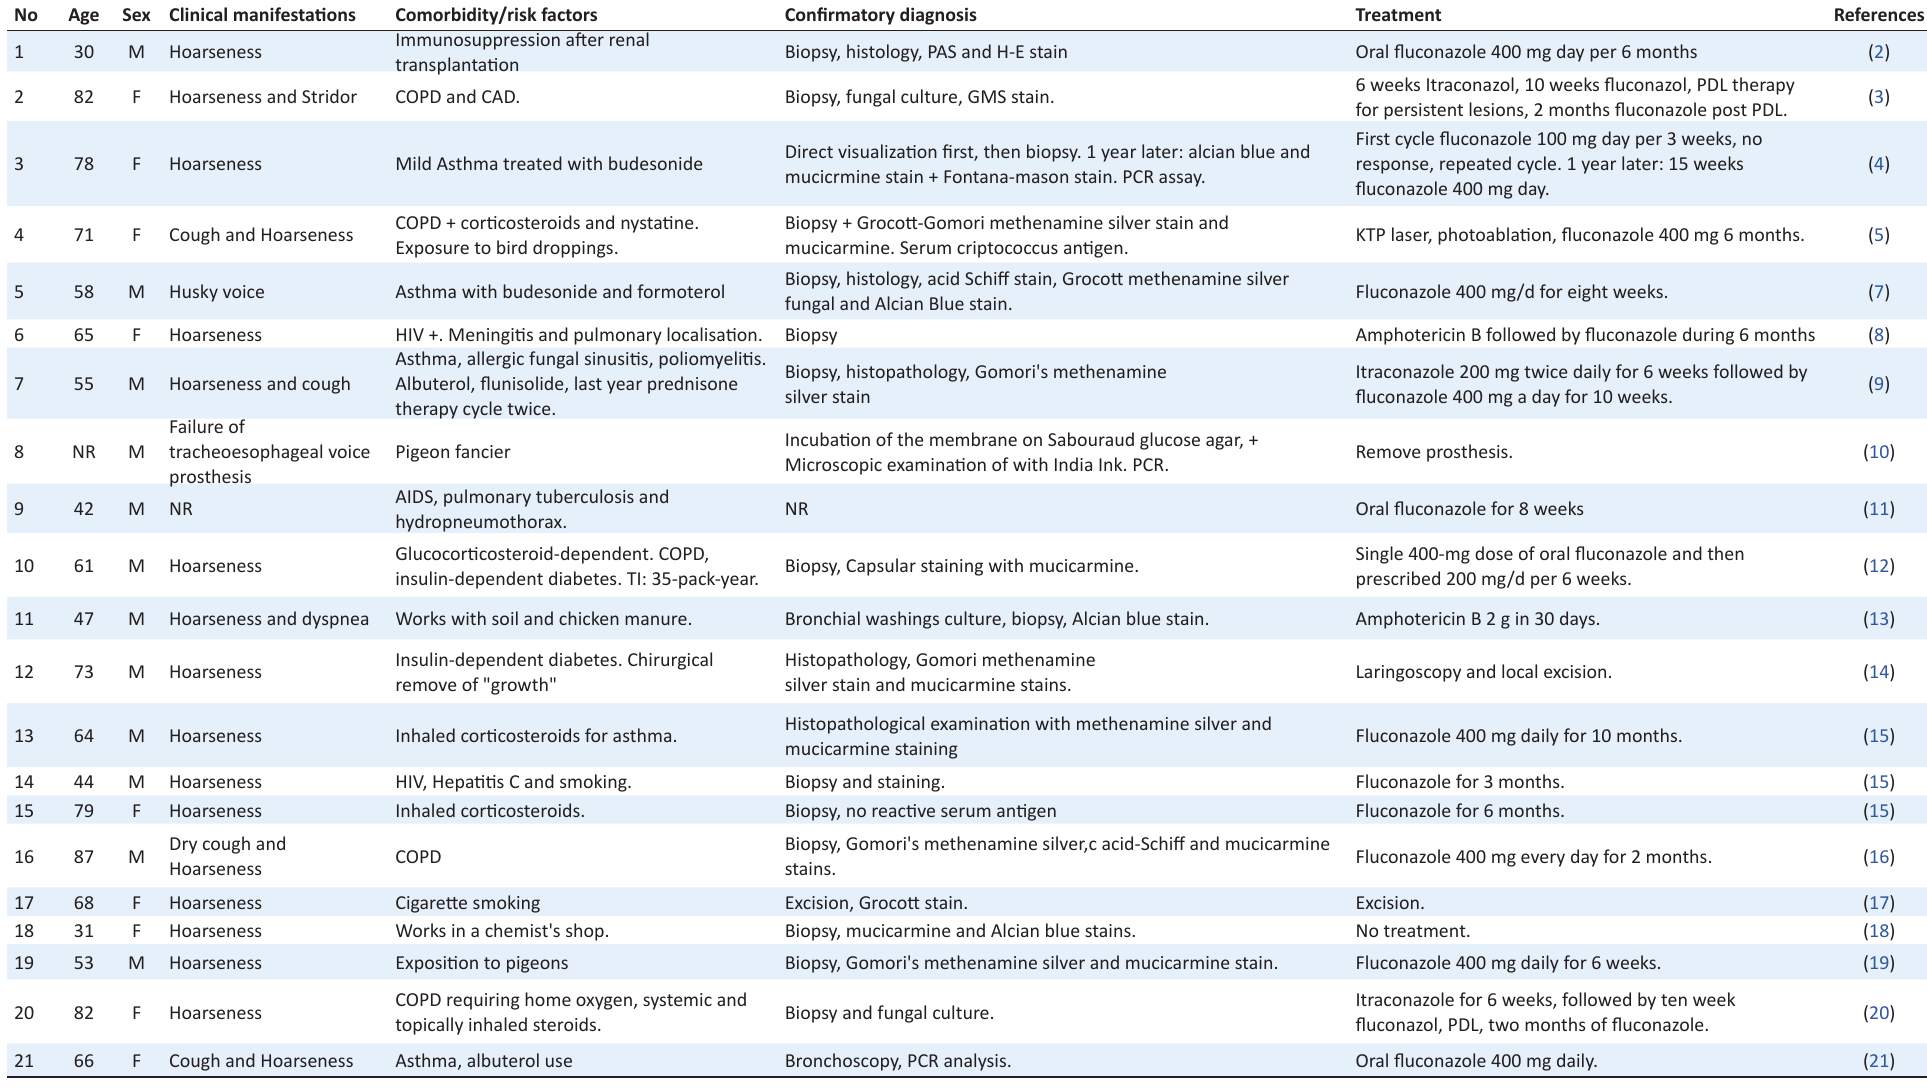
Table 1. Reported cases of laryngeal cryptococcosis,